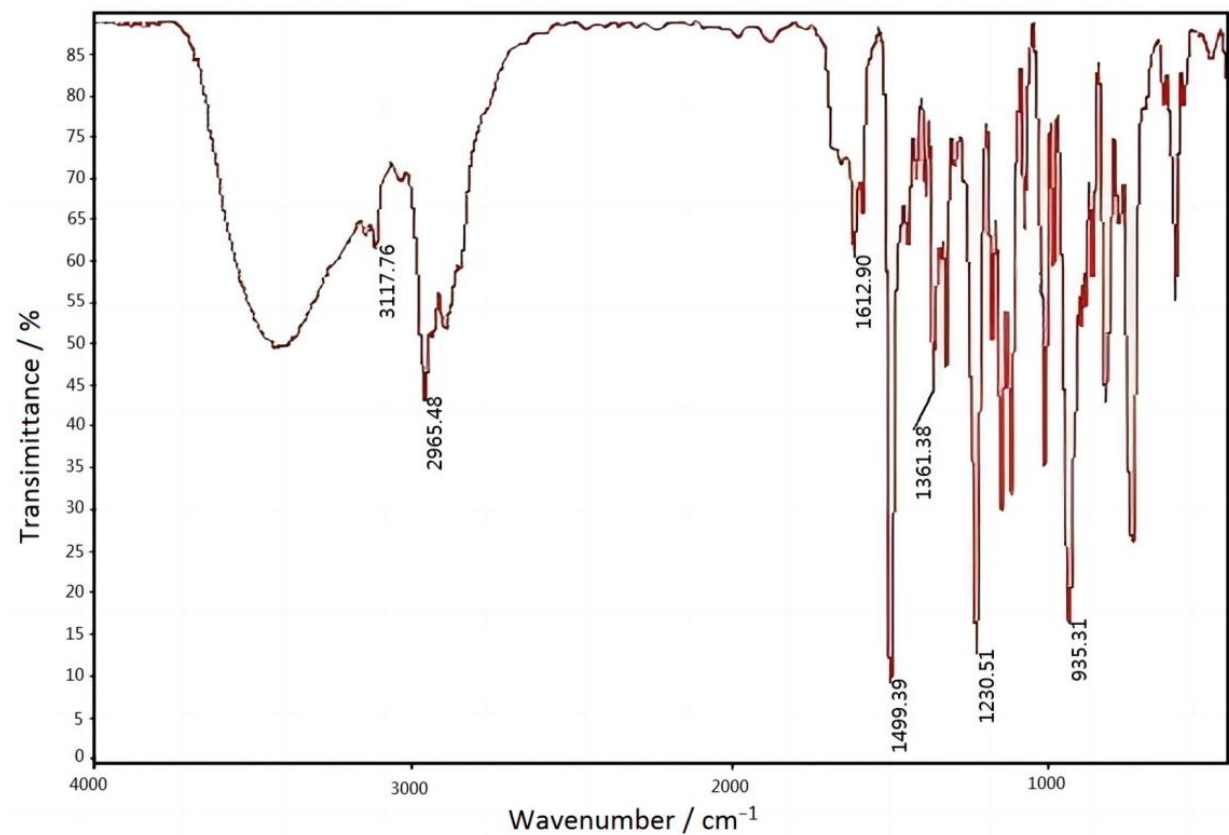
Figure 11. FTIR spectrum of benzoxazine (bisphenol A). Table 5. The result of FTIR spectrum of benzoxazine (bisphenol A)